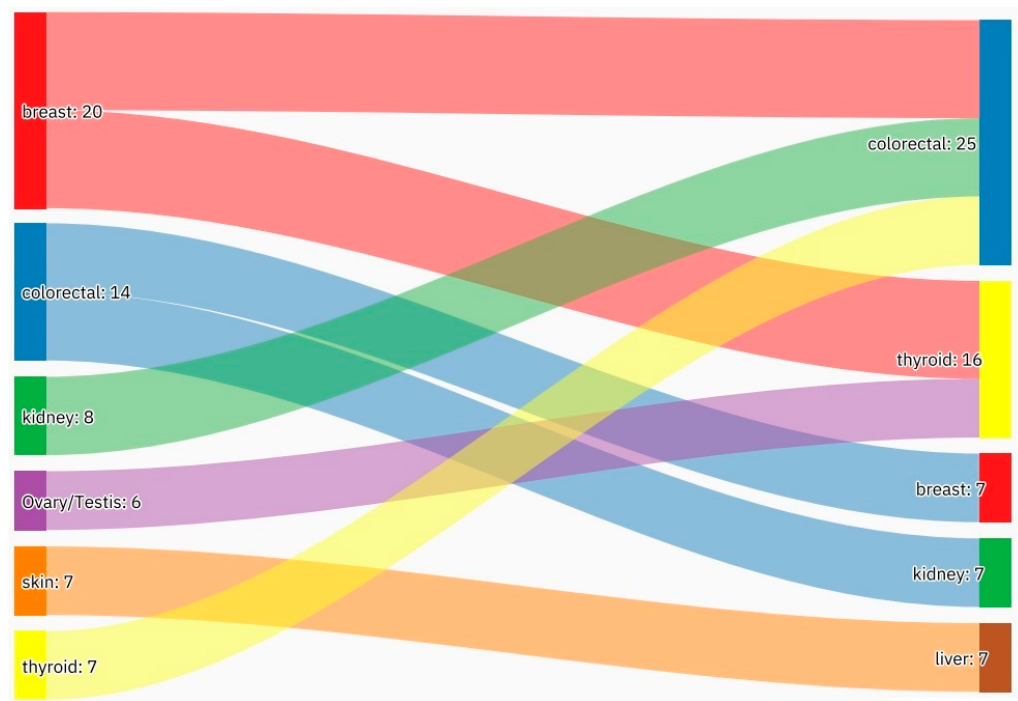
Figure 5. An alluvial plot showing the most frequent malignancy combinations. The most frequent malignancy combinations were breast–colorectal, breast–thyroid, kidney–colorectal, and colorectal– breast. Further frequent malignancy combinations are provided in Table 3.